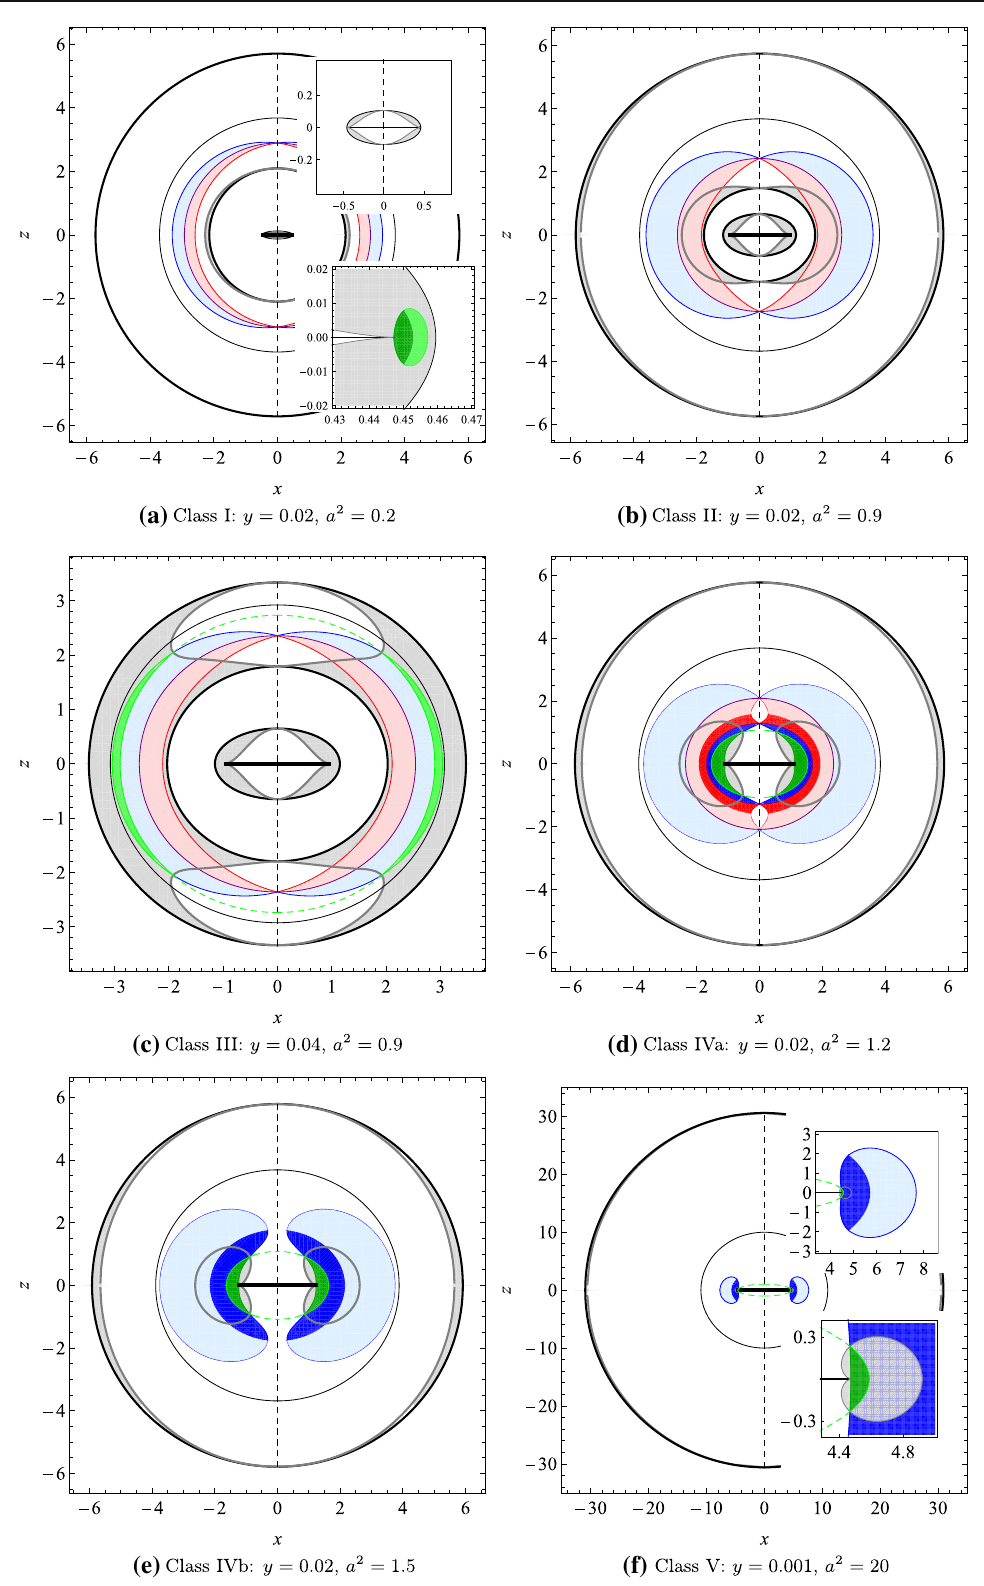
Fig. 12 Spherical photon orbits in individual classes of Kerr–de Sitter spacetimes. The class VIII is not presented, since the structure of the spherical orbits matches with the class VII, but it differs in character of the latitudinal